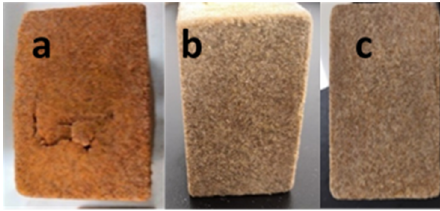
Figure 6. Three stone samples after eight cycles: ( a ) sample 1 # , ( b ) sample 2 # , and ( c ) sample 3 # .